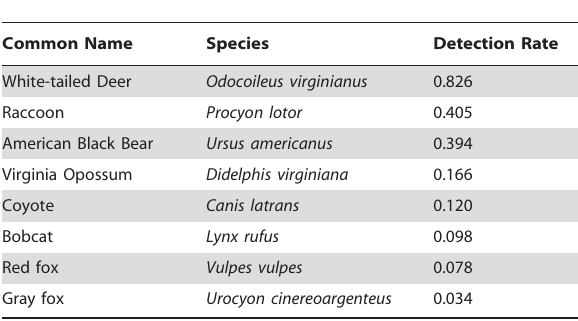
Table 2. Detection rates for 8 most common species detected in this